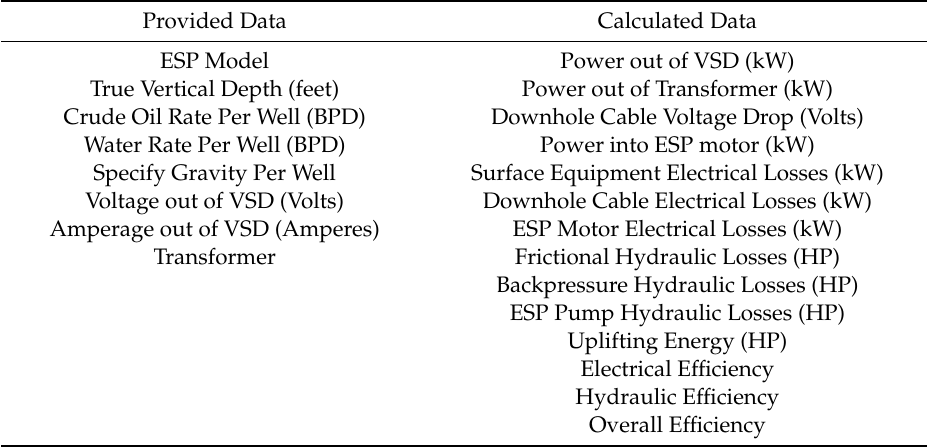
Table 3. Provided and derived ESP